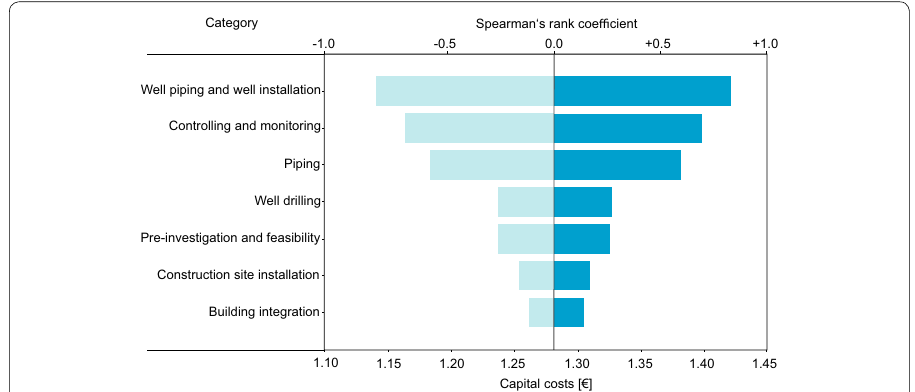
Fig. 6 Spearman’s rank coefficients representing the degree of correlation between the input parameters of the different categories to the variance of the capital costs. The relative importance of the single categories of the ATES system on the capital costs is also illustrated